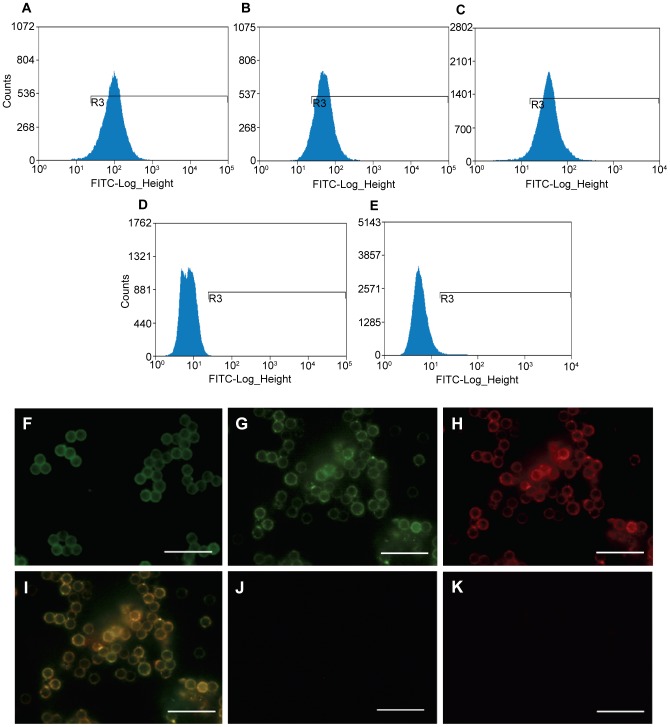
Endometrial exosomes/microvesicles are identified by FACS analysis when bound to latex beads.A–E. Appropriate gating demonstrated strong intensity for each of the exosomal surface proteins, CD9, CD63 and CD81 (Figs. 2A, B, C respectively). Controls - beads alone similarly incubated with isotope specific FITC or PE-labelled IgG (Figs. 2D, E respectively). F–K. Immunostaining of the same beads clearly visualised these same markers on the surface of the beads (F–H respectively): this staining colocalized for CD63 and CD81 shown in I. Negative controls (J,K) (bars, 20 µm).